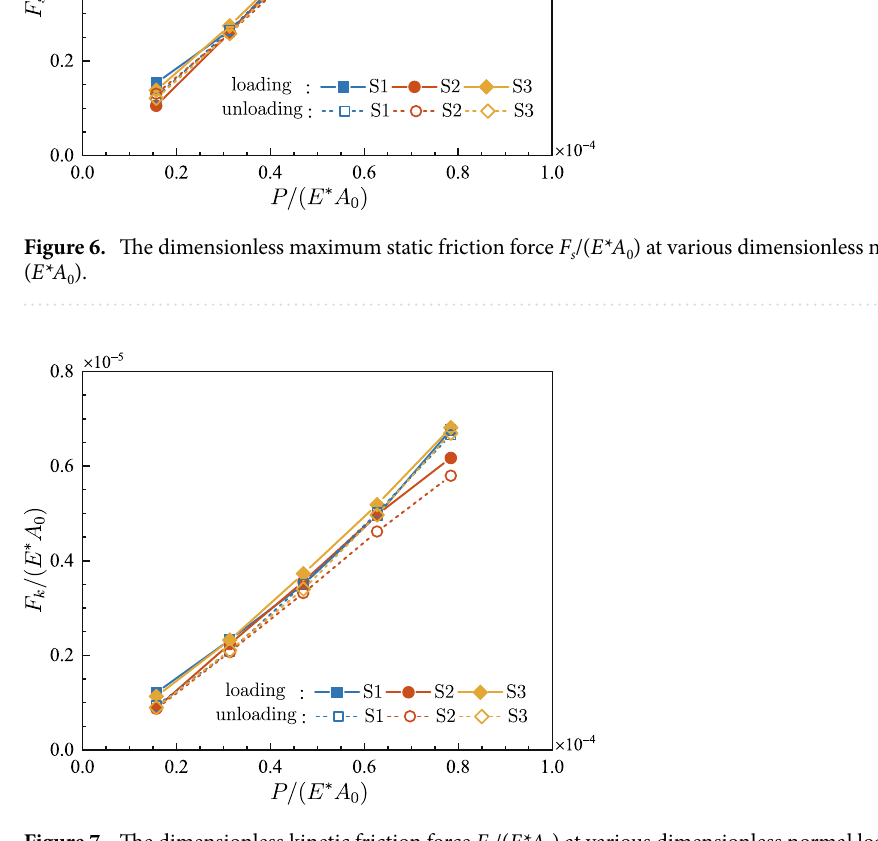
Figure 7. The dimensionless kinetic friction force F k /( E*A 0 ) at various dimensionless normal loads P /( E*A 0